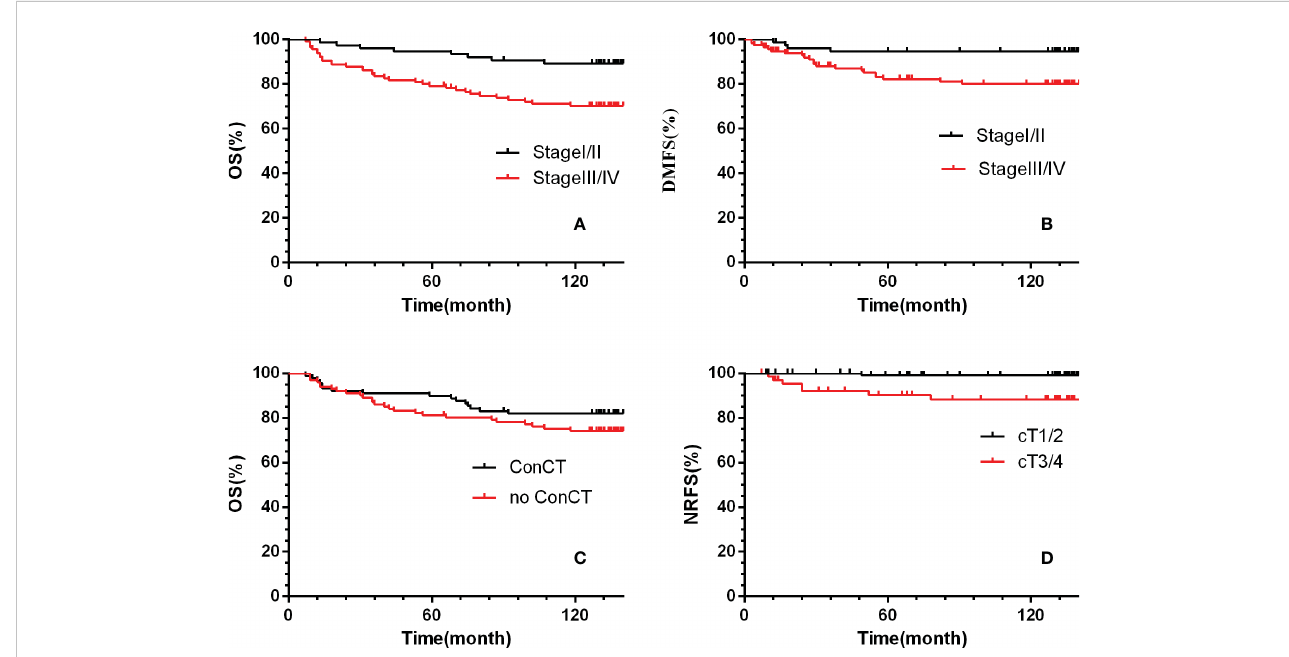
FIGURE 2 Kaplan-Meier survival curves for the two treatment groups. (A, C) overall survival, (B) distant metastasis-free survival, (D) nodal relapse-free survival. ConCT=concurrent